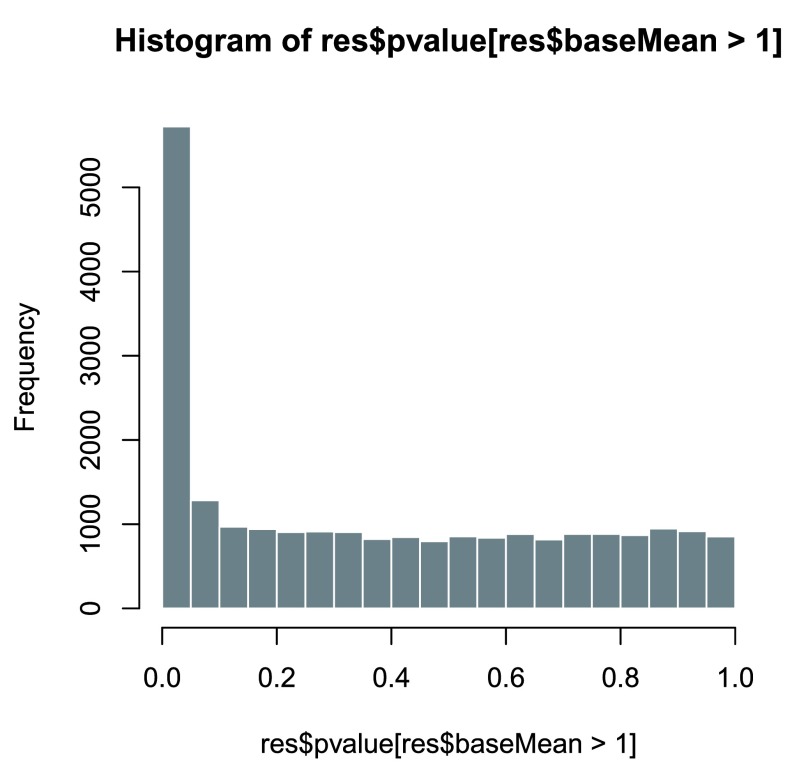
Histogram of
p values for genes with mean normalized count larger than 1.